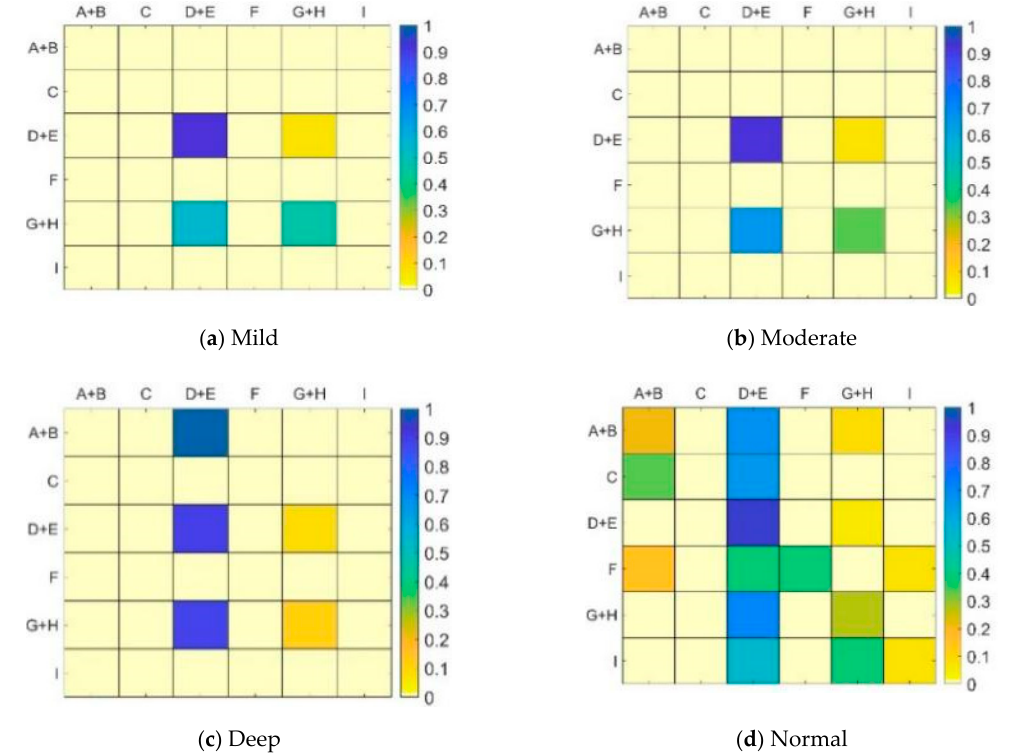
Figure 10. One-step transition probability matrix under different states. ( a ) Mild ( b ) Moderate( c ) Deep ( d ) Normal.